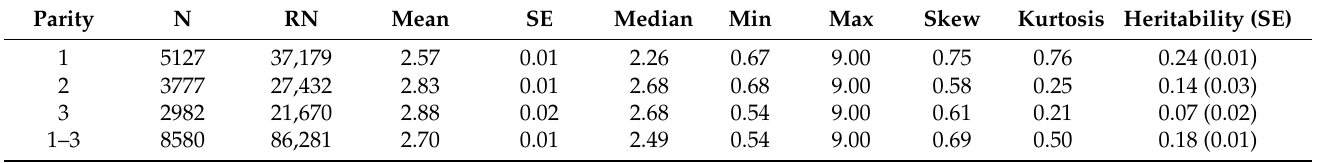
Table 1. Descriptive statistics and estimated heritability of SCS records of Holsteins of different